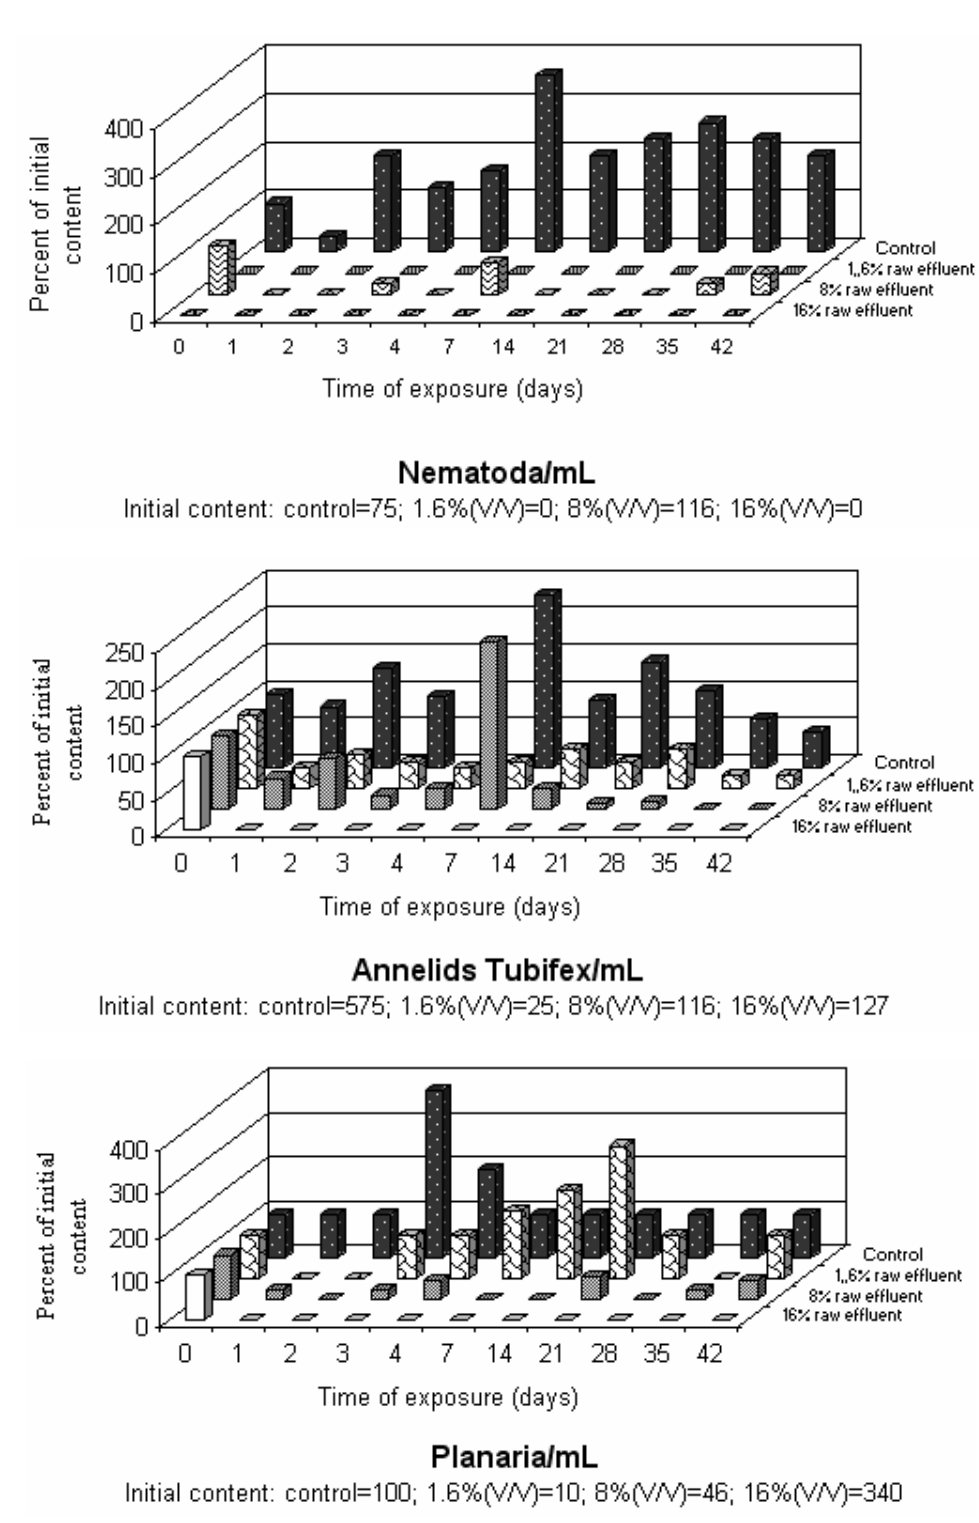
Figure 5: The effect of Pilcam effluent on benthic macro-invertebrates density of untreated and treated